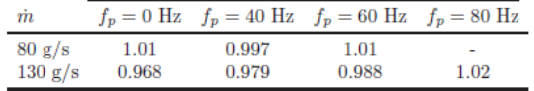
Table 2. Relative deviations of mean mass flow measured by hot-wire probe from reference value for given flow pulsation frequencies [6].